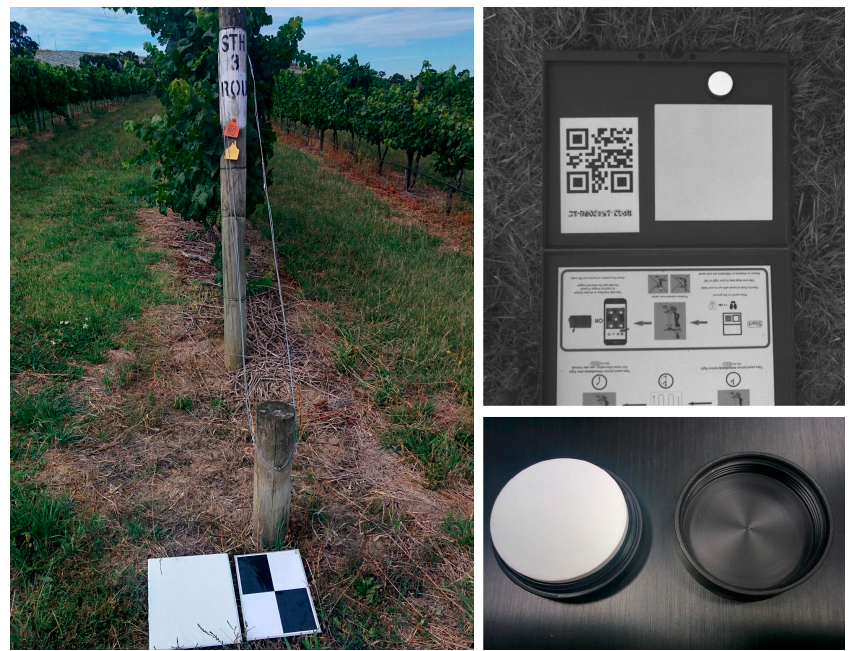
Figure 2. Ground control point (GCP) target and white reference board ( left ), MicaSense reflectance reference board ( top right ), and Spectralon white reference ( bottom right ).